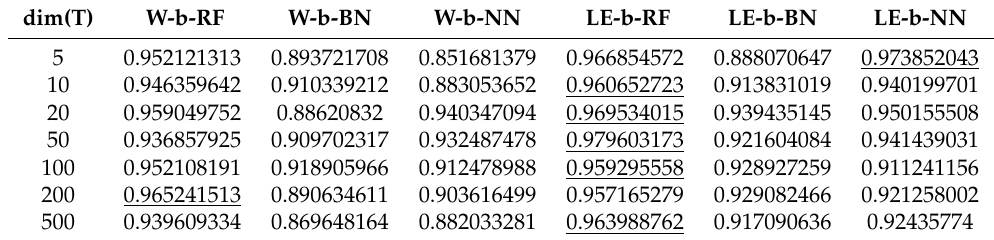
Table 7. AUC with different dimensions.